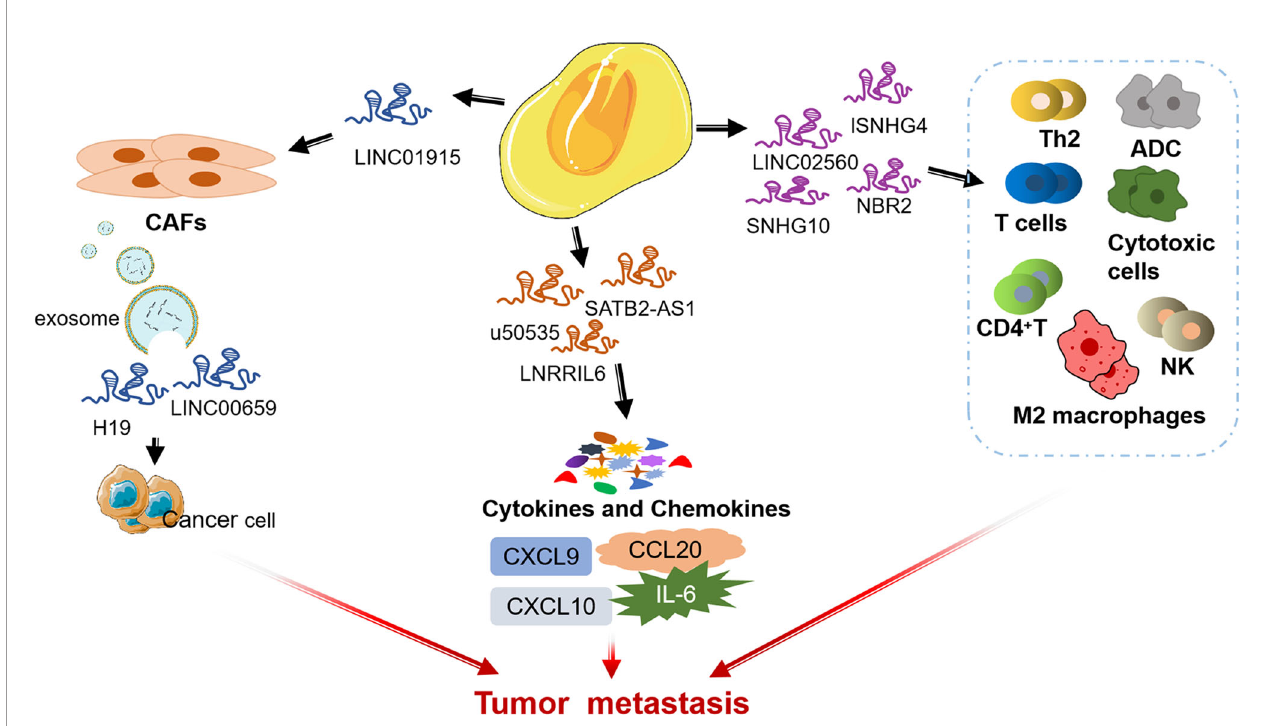
FIGURE 3 | lncRNAs involved in the physical regulation of CRC in